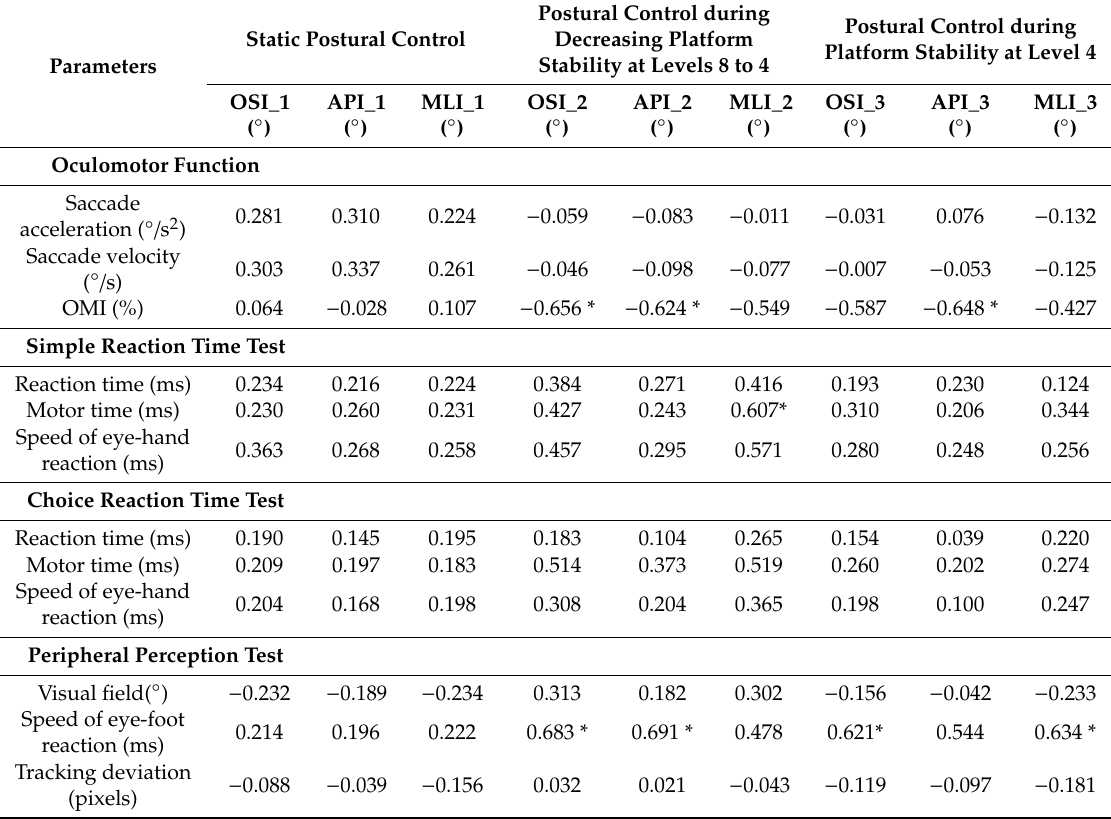
Table 1. Pearson correlation coe ffi cient for postural stability, oculomotor function, simple reaction time, choice reaction time, and peripheral perception